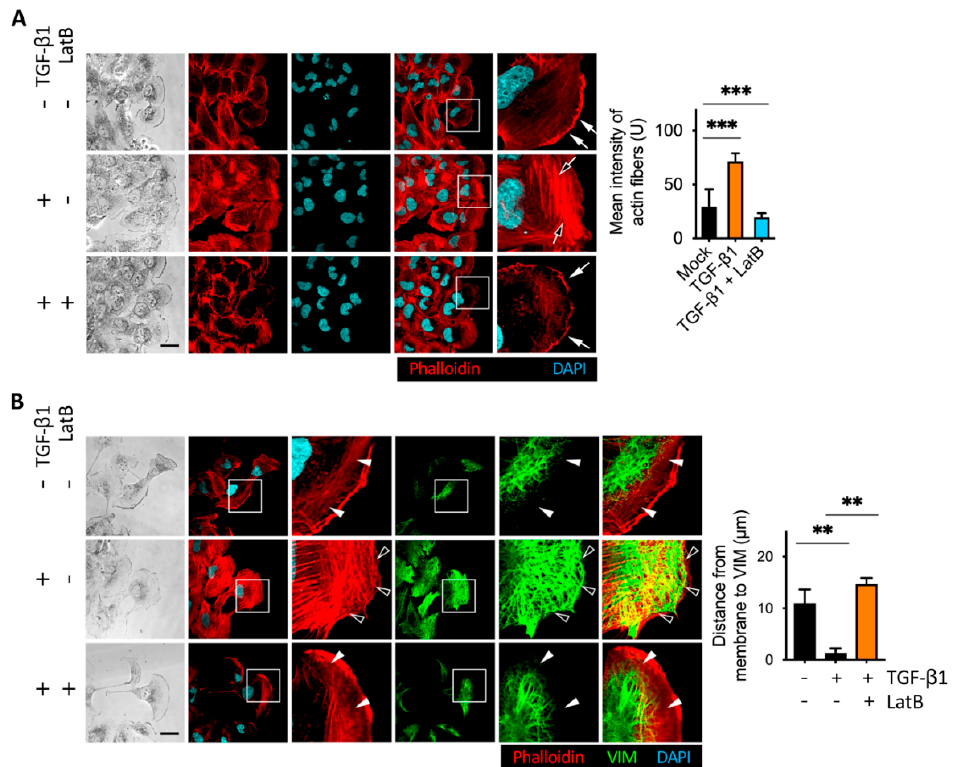
Figure 5. Latrunculin B disrupted TGF- β 1-mediated actin stress fibers formation and vimentin intermediate filament networks. ( A ) Images of representative immunofluorescence results revealed that the addition of latrunculin B disrupted TGF- β 1-induced actin stress fibers formation. BFTC909 cells were seeded in the wound healing chamber overnight, followed by migration with or without treatment of TGF- β 1 ligands or latrunculin B for 24 h. Black arrow: actin stress fibers. White arrow: lamellipodia. Scale bars: 10 µ m. *** p < 0.001. Data are means ± s.d. (one-way ANOVA with Dunnett’s multiple comparisons test) from experiments with three replicates ( n = 3). ( B ) Treatment of latrunculin B repressed vimentin intermediate filament networks in BFTC909. Migration was performed with or without treatment of TGF- β 1 ligands or latrunculin B for 24 h. Arrowheads: the space between the intracellular membrane and vimentin. Scale bars: 100 µ m. ** p < 0.01. Data are means ± s.d. (one-way ANOVA with Dunnett’s multiple comparisons test) from experiments with three replicates ( n = 3). LatB, latrunculin